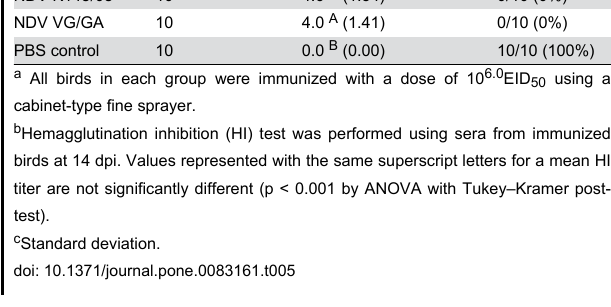
Vaccine strain a Number of birds Mean HI titer b (S.D. c )